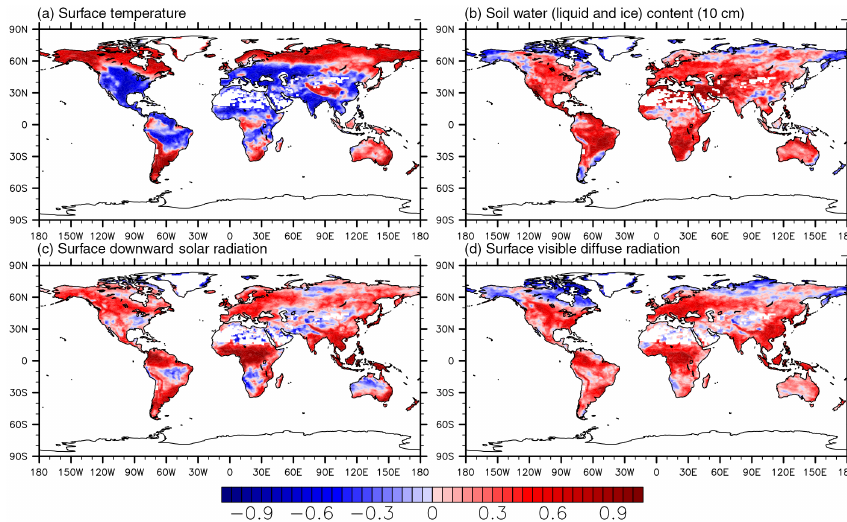
Figure 5. Correlation coefficient of the monthly photosynthesis rate anomalies in JJA during years 2030–2069 (G4SSA minus RCP6.0, Fig. 3a) and (a) surface temperature anomalies, (b) top 10cm soil water (including liquid water and ice) anomalies, (c) surface